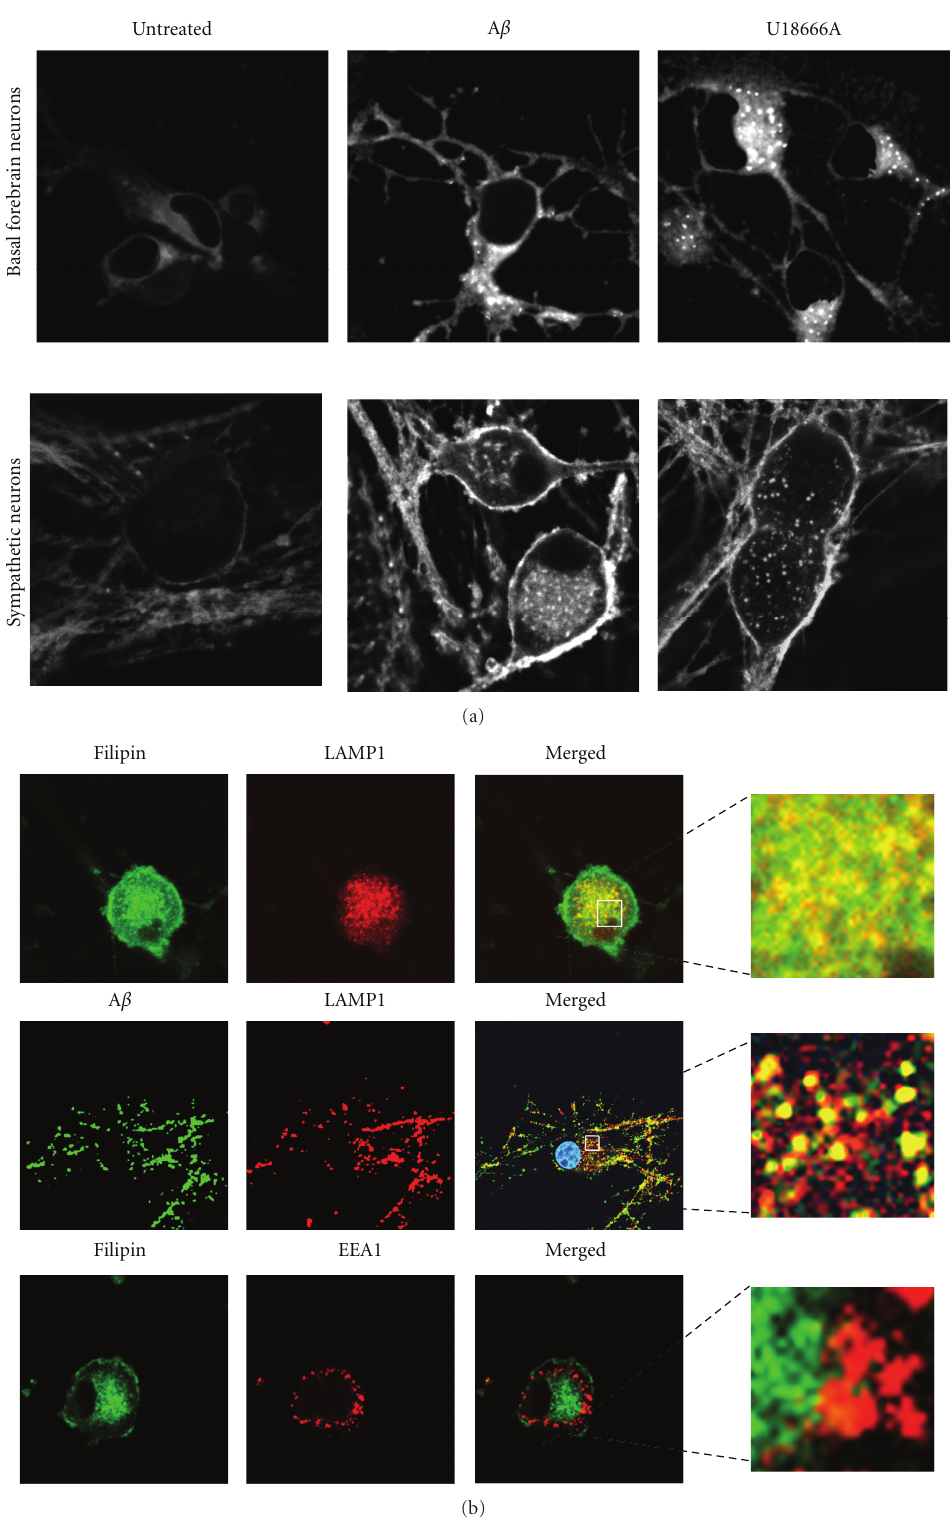
Figure 2: A β causes cholesterol sequestration in primary neurons. (a) Rat primary neurons (forebrain and sympathetic) cultured in serum- free medium, were treated for 24h with 20 μ M oligomeric A β 42 (prepared according to [66]) or with 1.5 μ M U18666A, a drug extensively used to induce cholesterol sequestration. Cholesterol was examined by confocal microscopy, using filipin. (b) Neurons were treated as in (a) but fluorescent oligomeric A β 42 was used. Intracellular localization of cholesterol and A β was examined by double indirect immunofluorescence confocal microscopy using LAMP1 as a marker of late endosome/MVBs and EEA1 as a marker of early